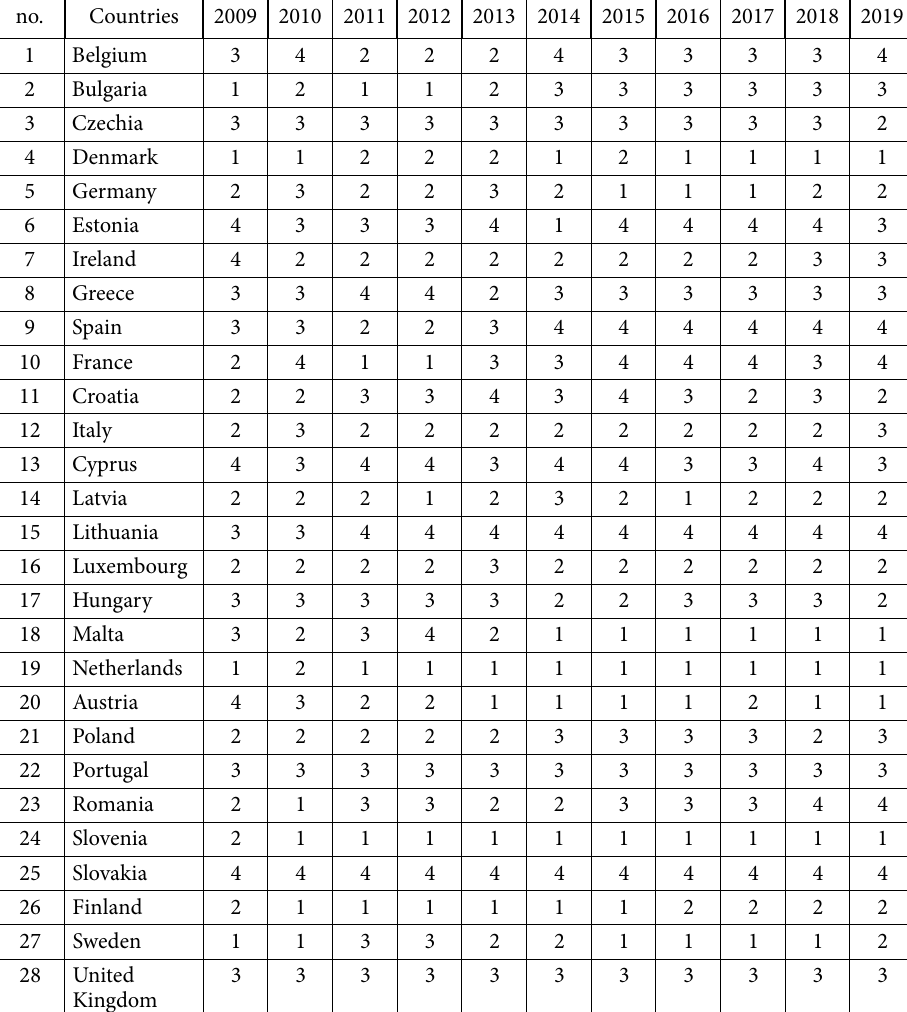
Table 3. EU countries by typological groups in